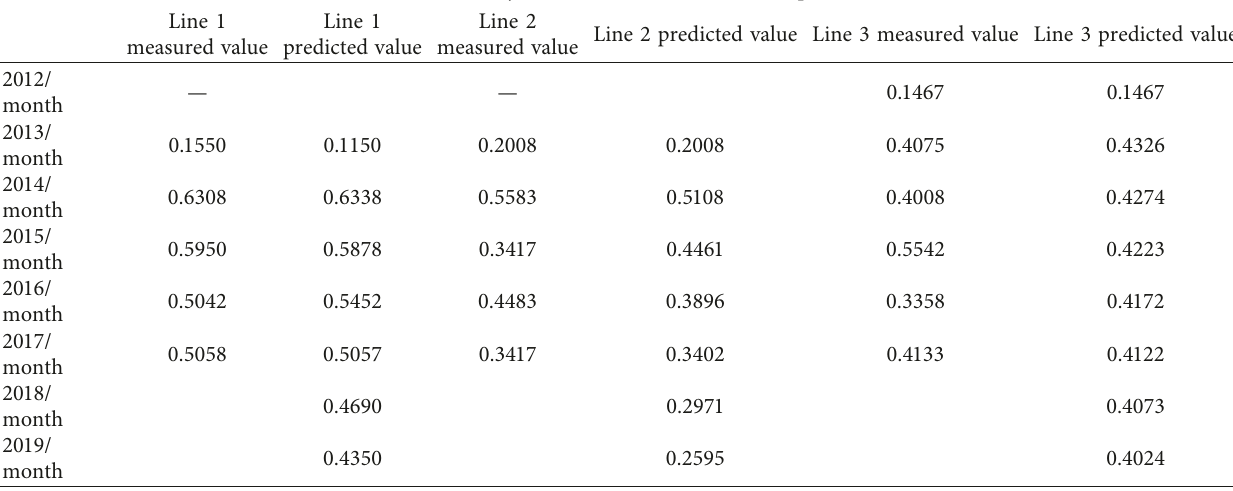
Table 9: Monthly attenuation prediction of three typical expressway pavements of the Hunan main highway. Monthly attenuation of measured and predicted PCI